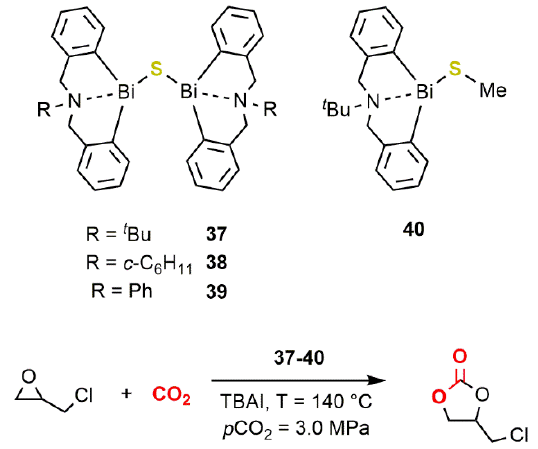
Figure 21. Dinuclear sulfide-bridged complexes 37–40 [80].